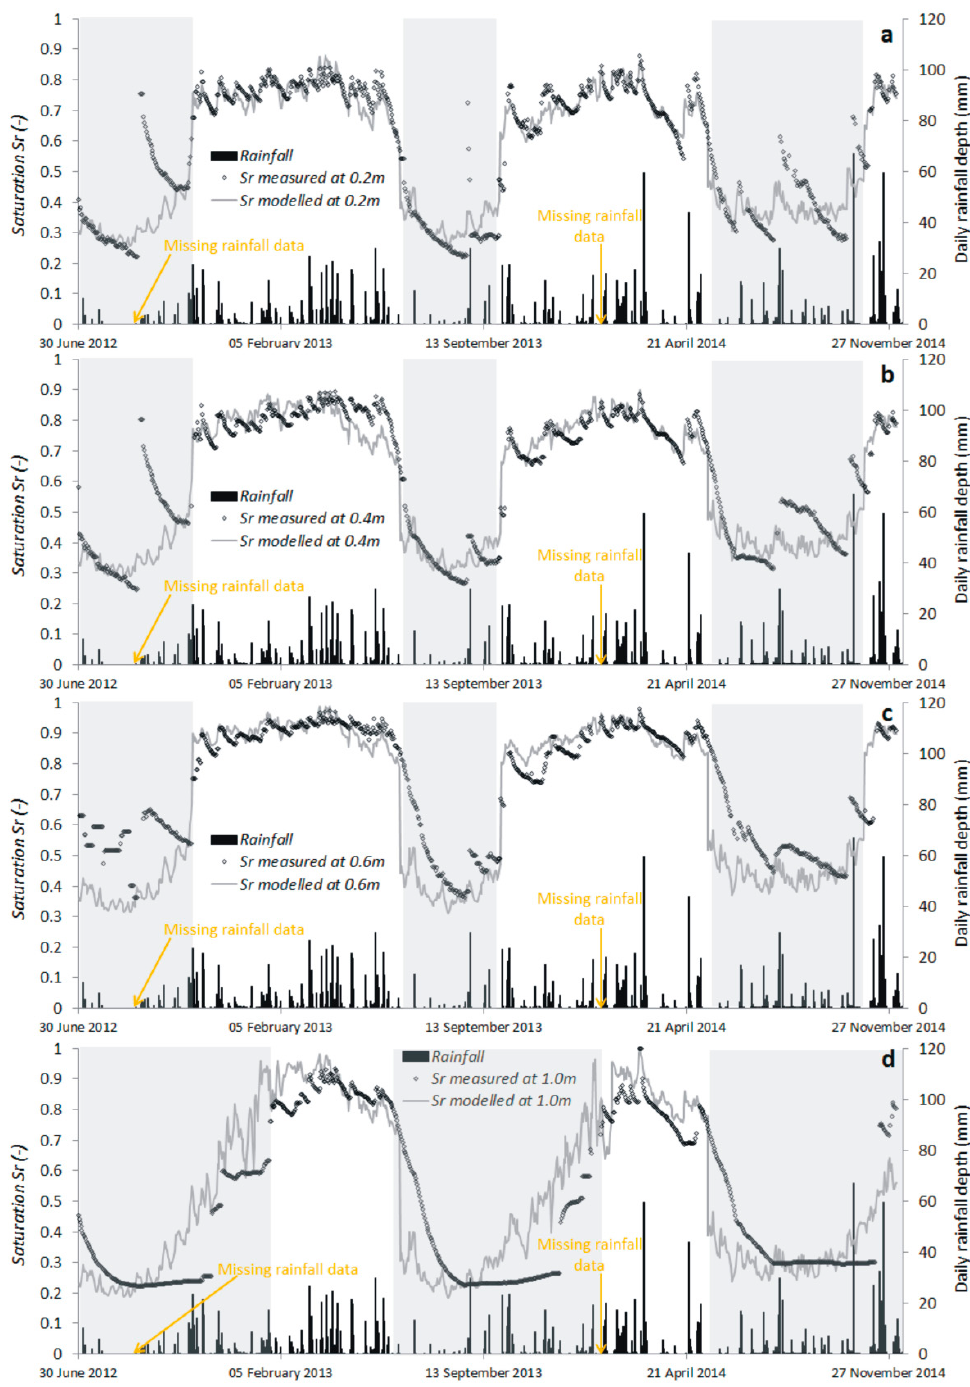
Figure 7. Comparison between the measured and modeled values of the degree of the soil saturation during the monitoring time span at various depths belowthe ground level: ( a ) 0.2 m; ( b ) 0.4 m; ( c ) 0.6 m; and ( d ) 1.0 m.The grey rectangles represent dry periods.